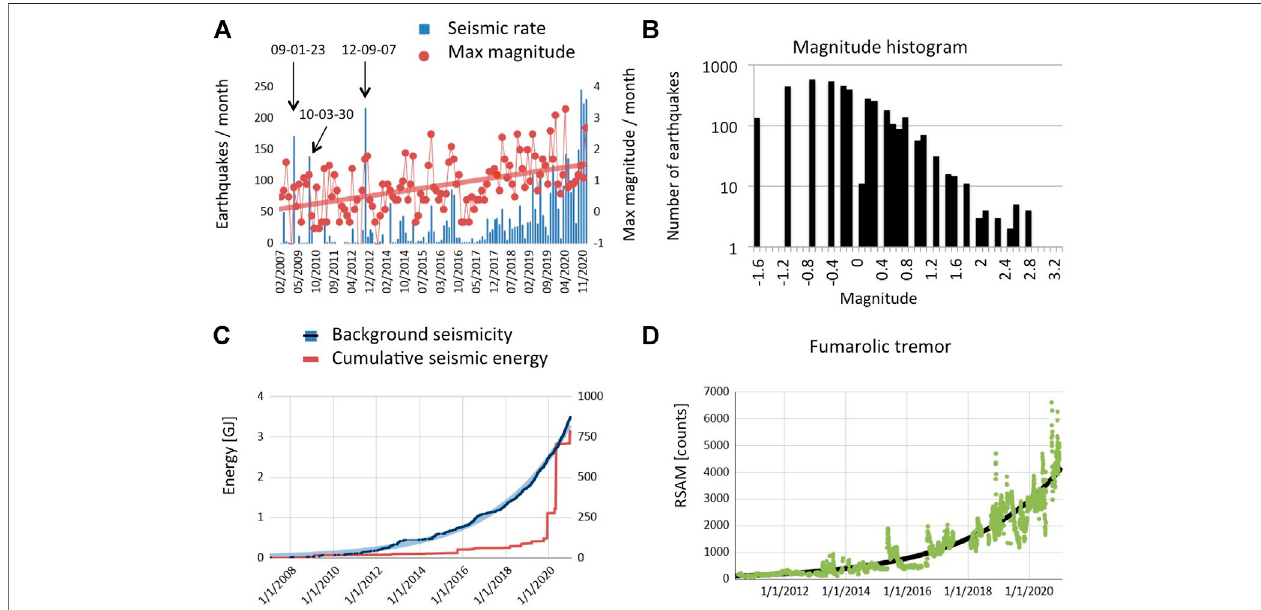
FIGURE 5 | Seismicity of Campi Flegrei. (A) Histogram of earthquakes per month detected by the STH seismic station since January 2007 (seismic catalog of Campi Flegrei, in supplementary Datasheet S1 ). The red curve with the circle markers shows the maximum magnitude of each month. (B) Histogram of earthquake magnitudes in the Campi Flegrei catalog (Log scale on vertical axis). (C) The red curve represents the cumulative seismic energy in GJ. The black curve is the ‘ background seismicity ’ de fi ned in Chiodini et al. (2017b) (right axis). The light blue curve represents an exponential trend line. It can be seen that the exponential trend closely approximates the temporal evolution of the ‘ background seismicity ’ . (D) In green the amplitude of the fumarolic tremor since January 2010 recorded at CPIS station that was installed on January 2010. The black curve represents an exponential trend line. It can be seen that also in this case the exponential trend closely approximates the temporal evolution of the fumarolic tremor indicating an acceleration of the ongoing